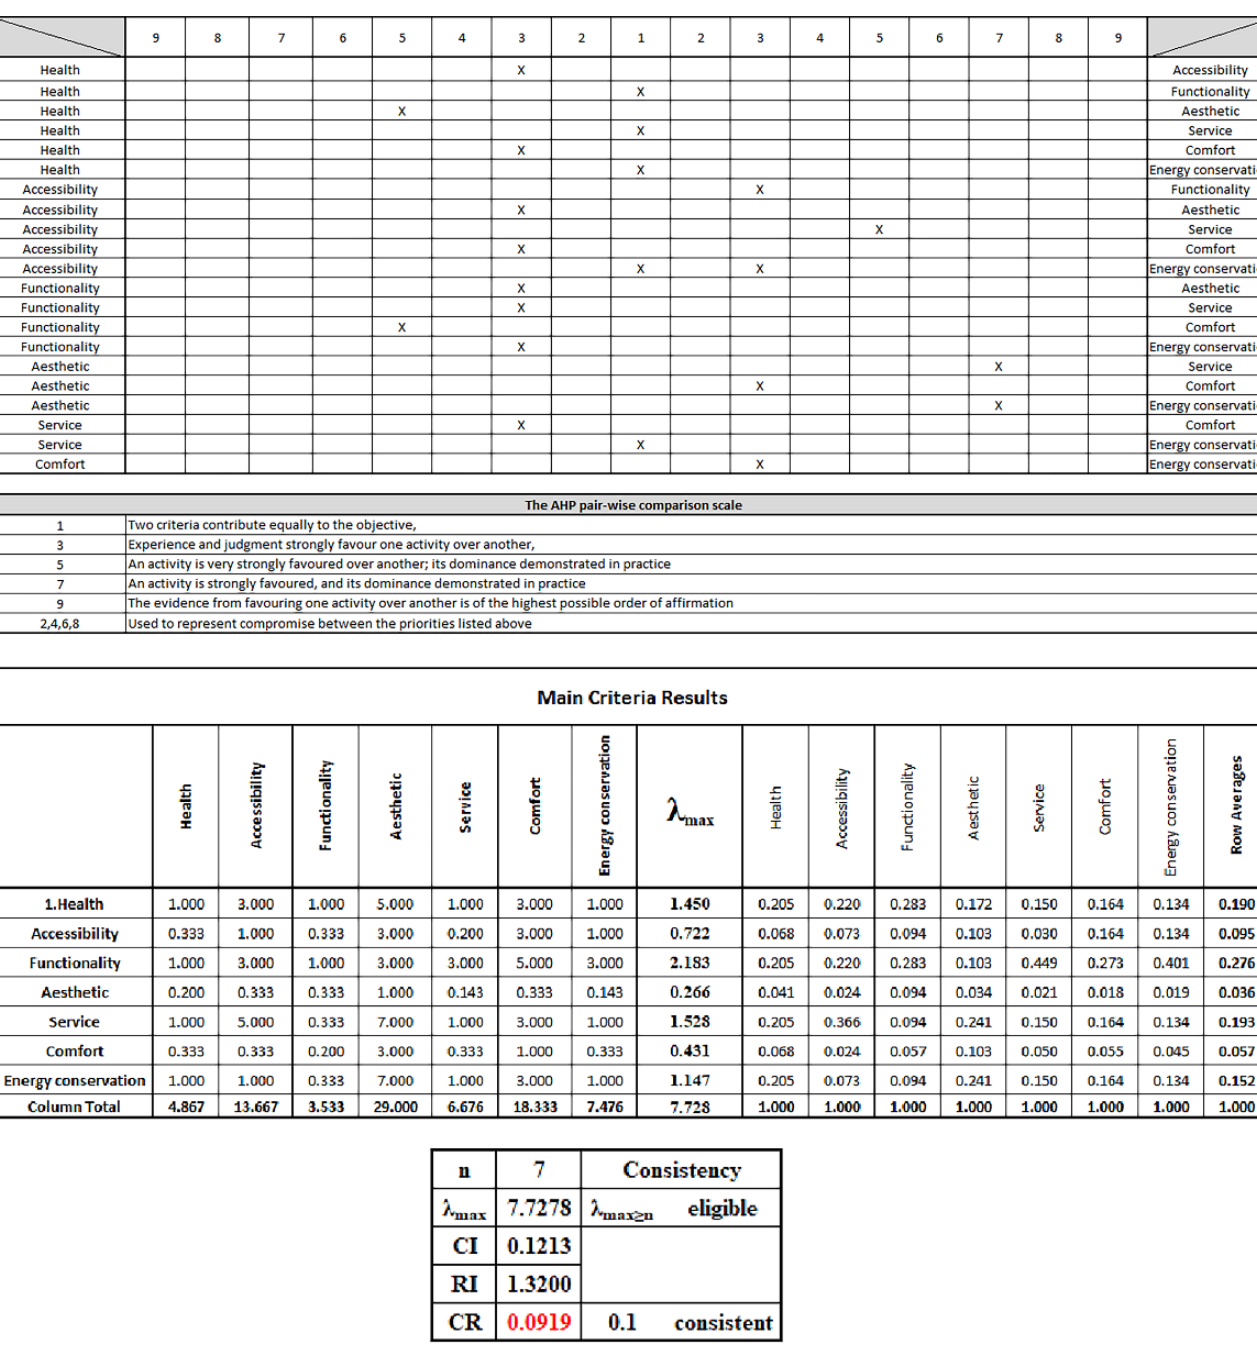
Figure 3. AHP pairwise comparison matrices result (example—Questionnaire 1).